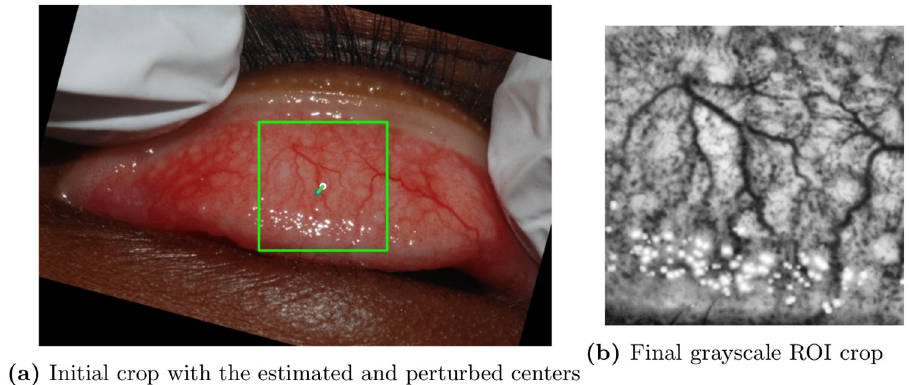
Fig 5. ROI crop selection procedure. (a) 256 × 256 crop on the rotated image. Estimated (white) and randomly perturbed eyelid centers (green) are shown. (b) Resulting 128 × 128 grayscale ROI.